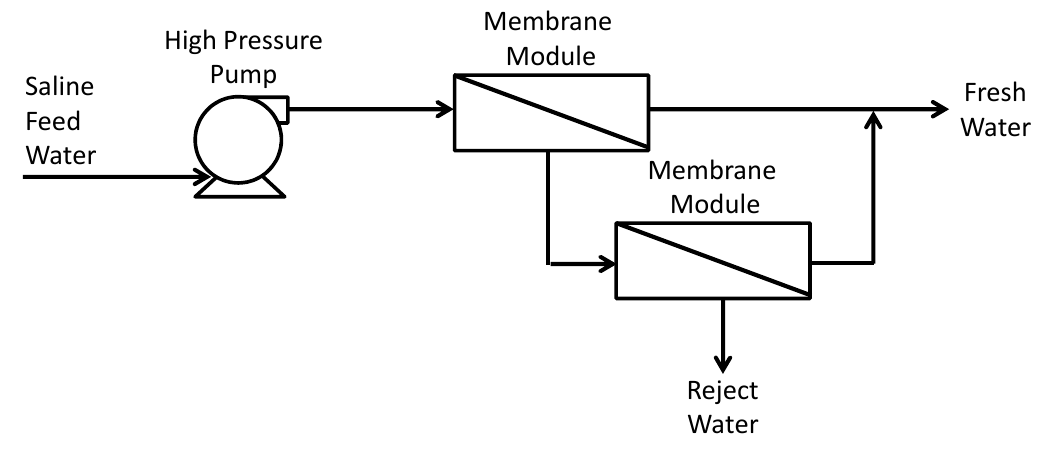
Figure 2. BWRO system with additional membrane module connected to the reject